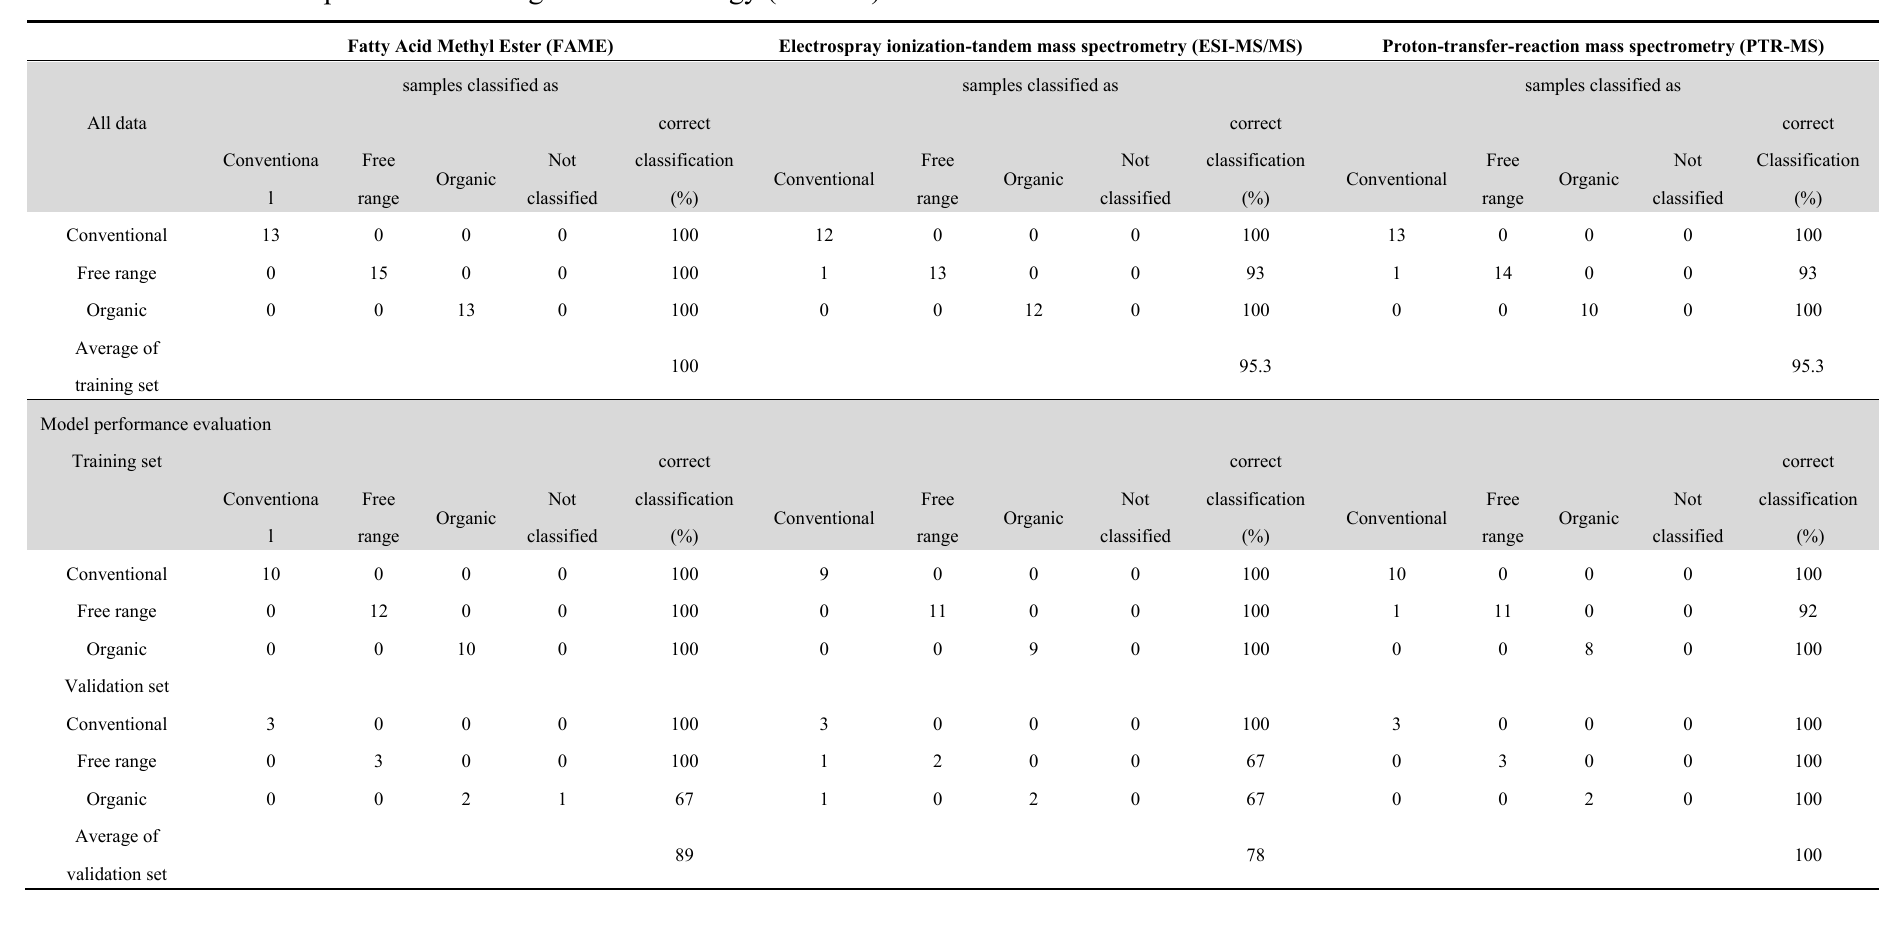
Table 1. Percentage of samples of pork belly meat from the categories conventional, free range and organic correctly classified in the training set of the Soft Independent Modeling of Class Analogy (SIMCA)